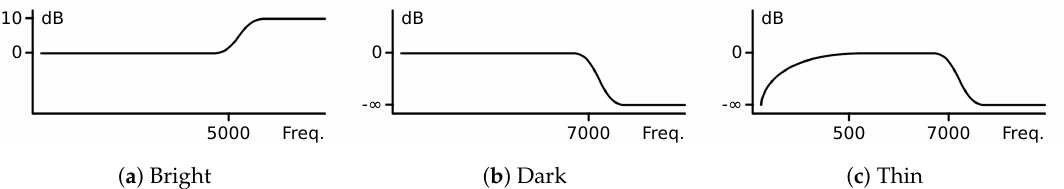
Figure 8. Frequency responses of the filters used to generate stereo anchor stimuli. ( a ) bright; ( b ) dark; ( c )